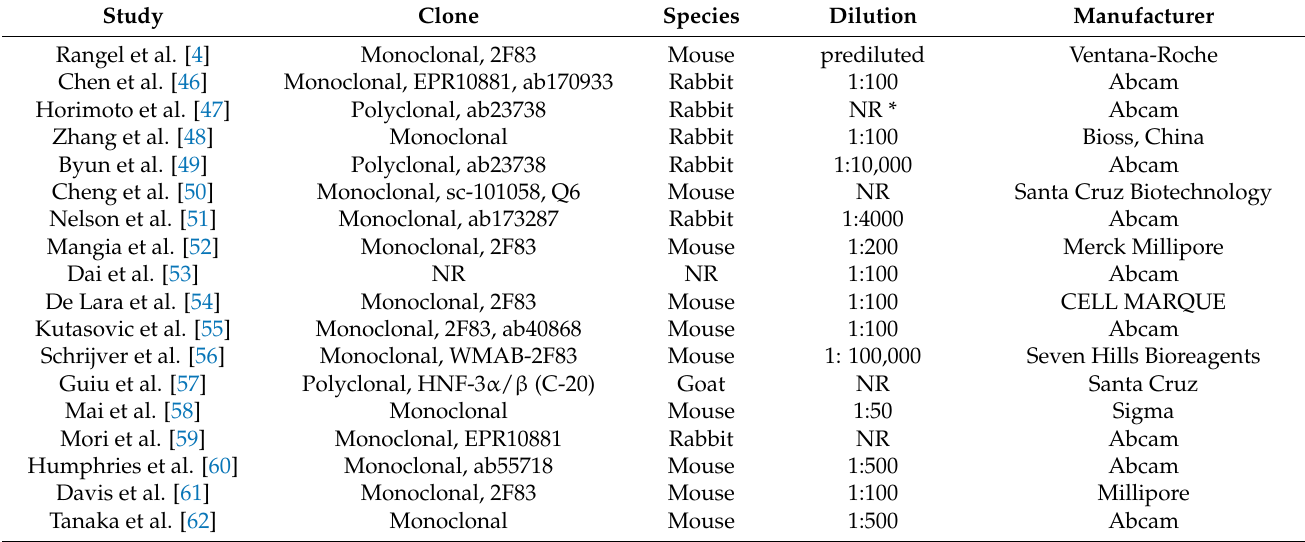
Table 1. Literature data regarding immunohistochemical analyses of FOXA1